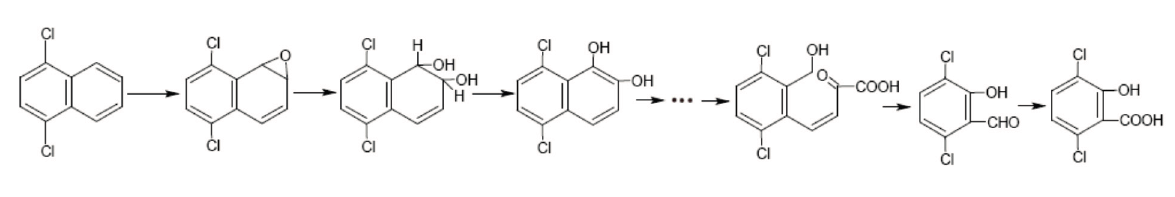
Figure 13. Metabolic pathway of